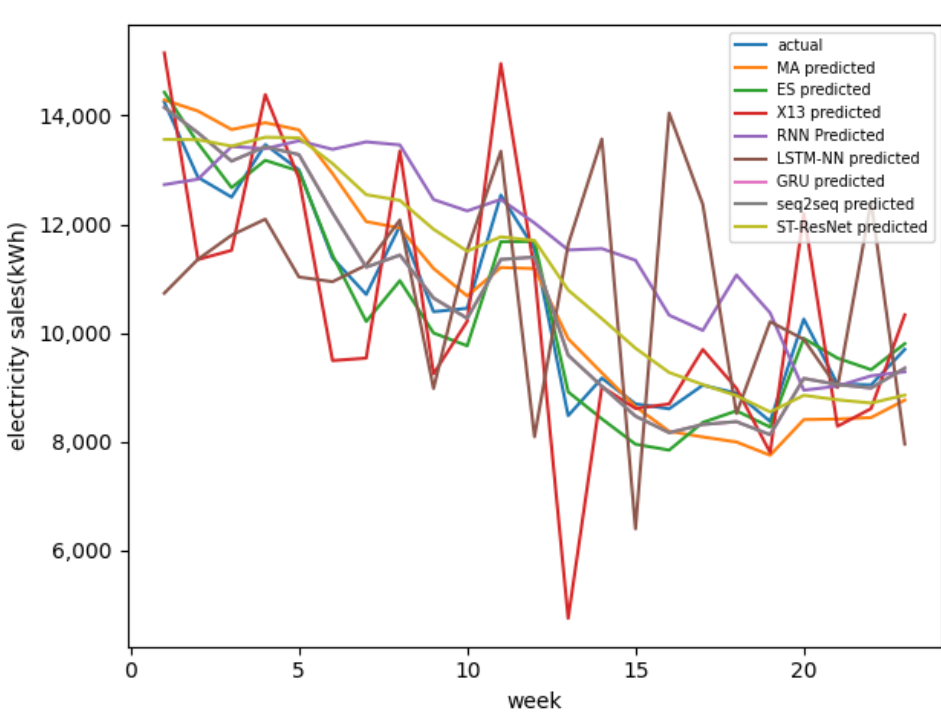
Figure 10. Comparison of medium-term